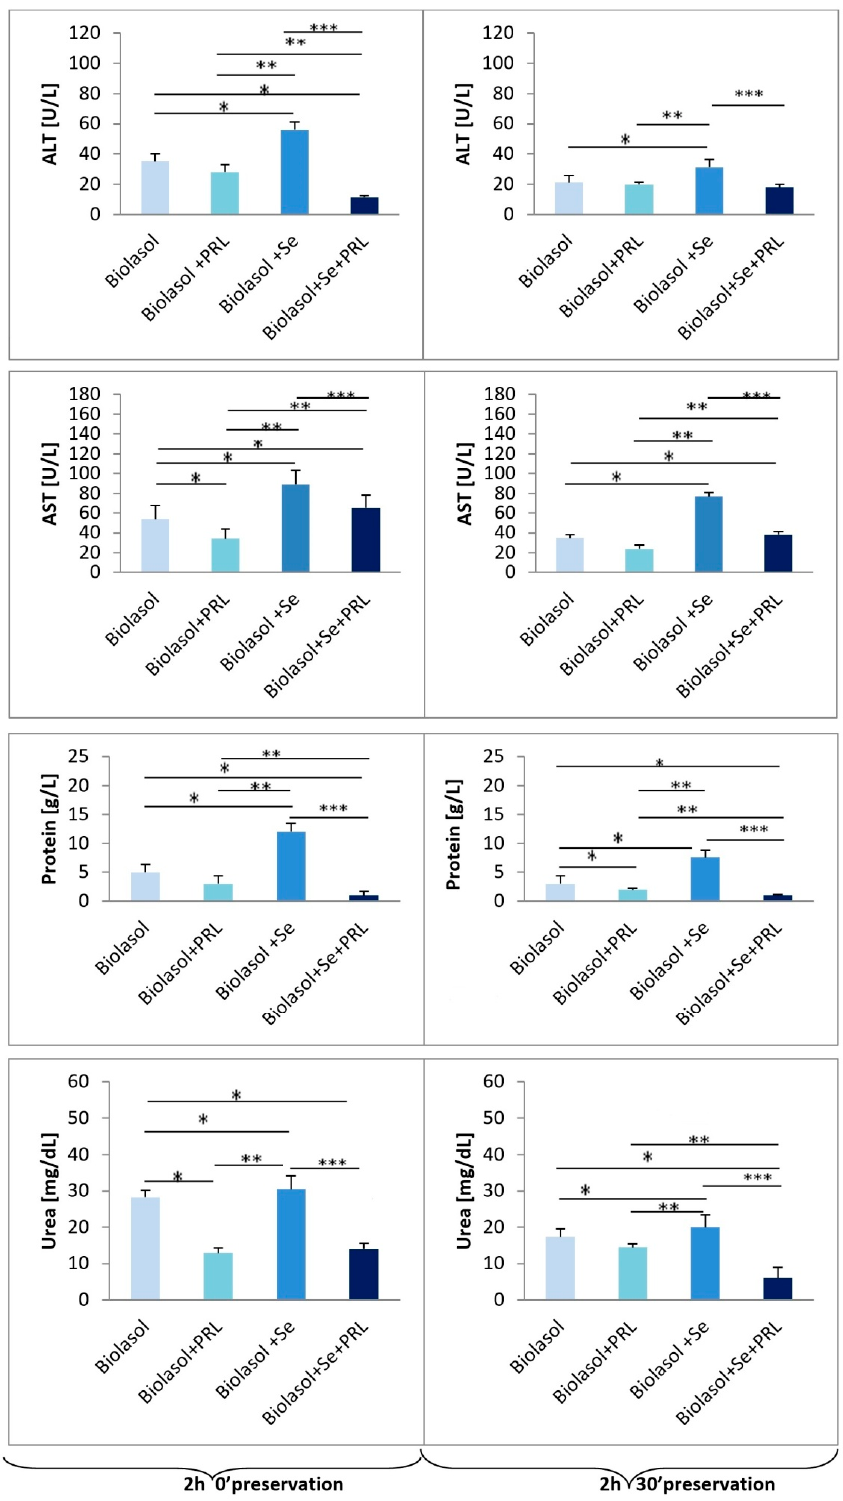
Figure 2. The effect of selenium on ALT, AST, protein, urea levels in porcine kidneys (2 h 0 ′ and 2 h 30 ′ preservation). Means ± standard deviations (SD) are shown. The symbols represent a significant difference ( p < 0.05) compared with the Biolasol ® group (*), the Biolasol ® +PRL group (**), and the Biolasol ® +Se group (***).